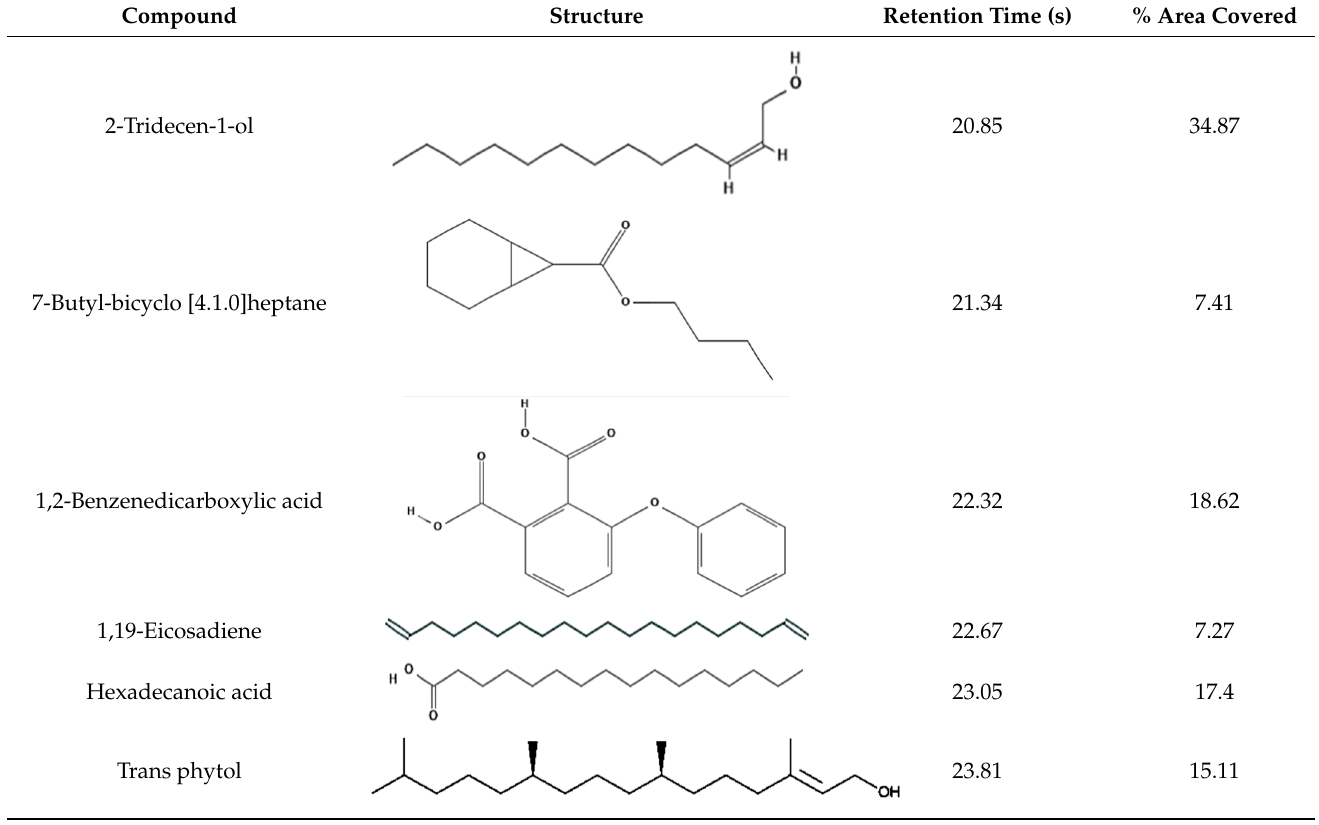
Table S3. Various tissue-specific fatty acid-binding proteins have been predicted with the highest % probability to be the protein target for hexadecanoic